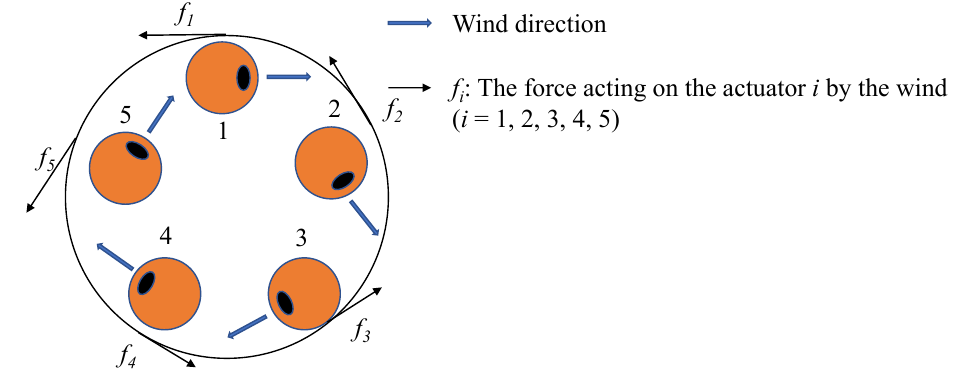
Figure 14. The force acting on the actuator by the wind.